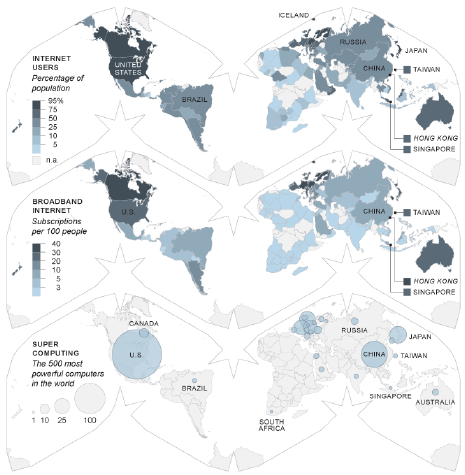
Fig. 18. “Butterfly” maps printed in the New York Times in 2011 (source: New York Times website)